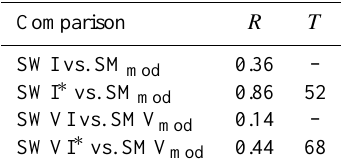
Table 3. Summary of the DREAM simulation in terms of simulated SM and SMV vs. AMSU based